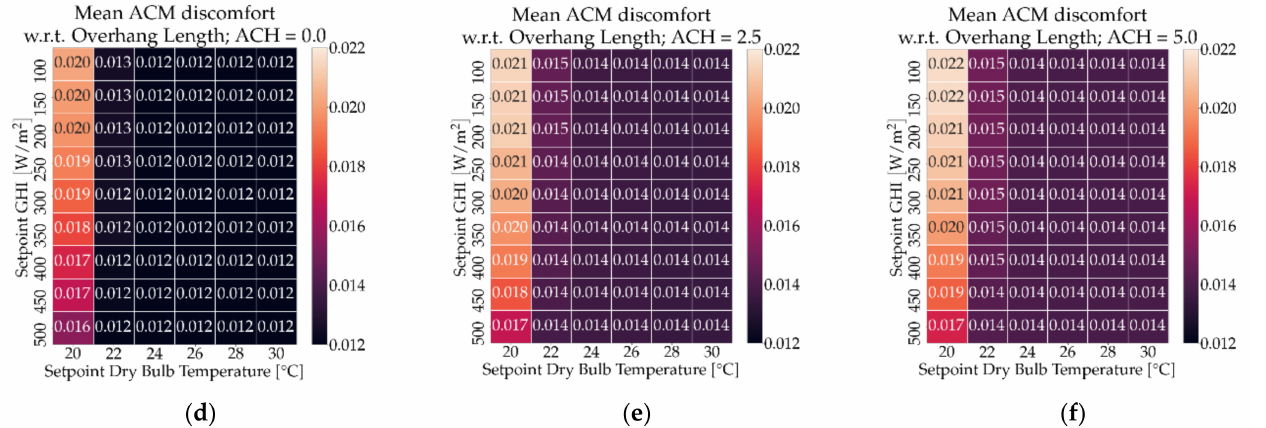
Figure 7. Simulated POR ( a – c ) and adaptive comfort model discomfort ( d – f ) in Torre Pellice. Outdoor temperature and global solar irradiation thresholds vary for activation of shade rolls.